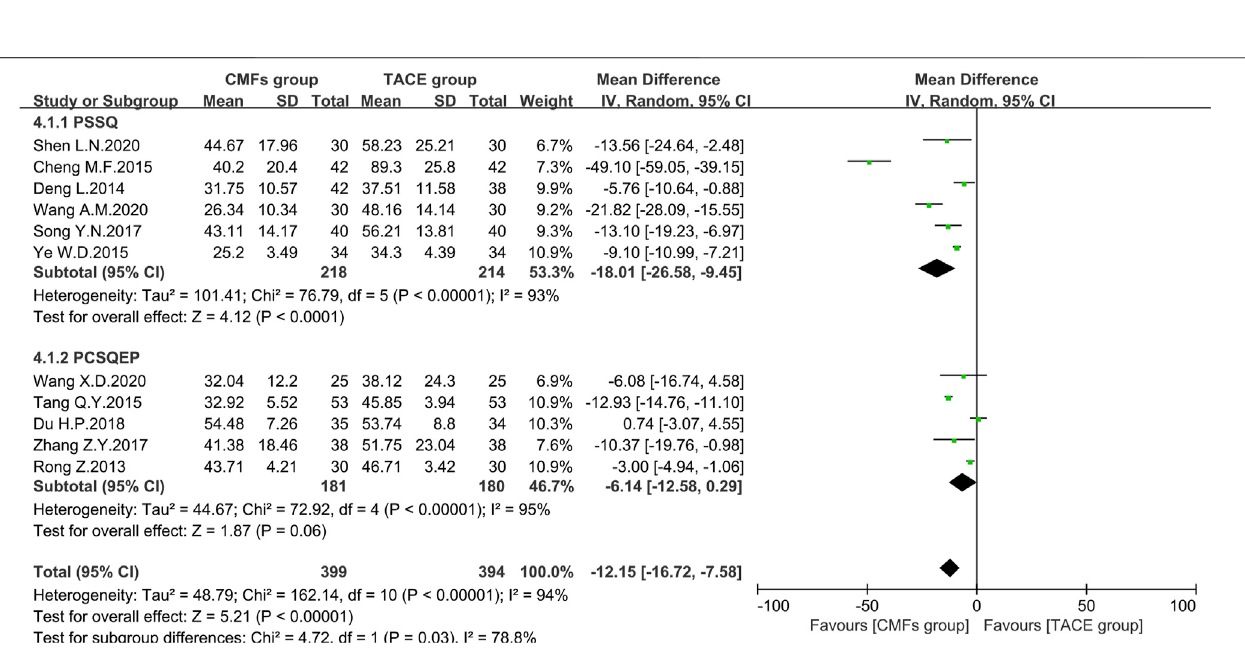
FIGURE 8 | Effect of CMFs group versus TACE group on ALT, including a comparison between PSSQ and PCSQEP in the subgroup.